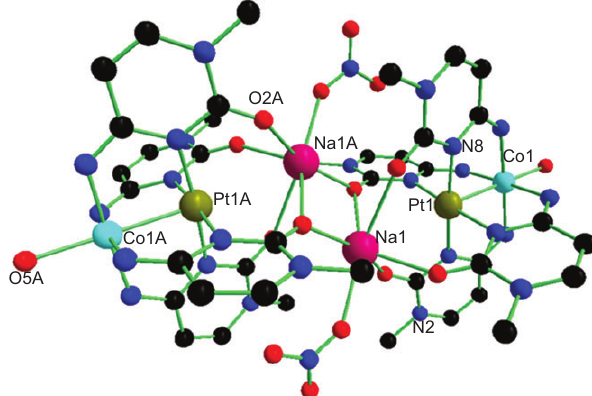
Figure 7 Molecular structure of [ { Pt( μ -mec) (Hegmans et al.,